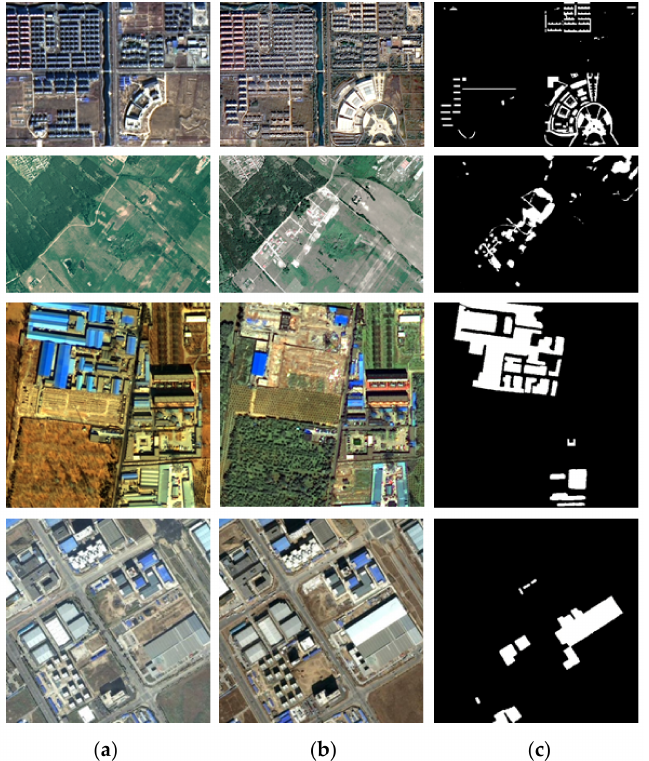
Figure 4. Image patch examples and corresponding reference images of optical data set: ( a ) Images from T1; ( b ) Images from T2; ( c ) Ground Truth.